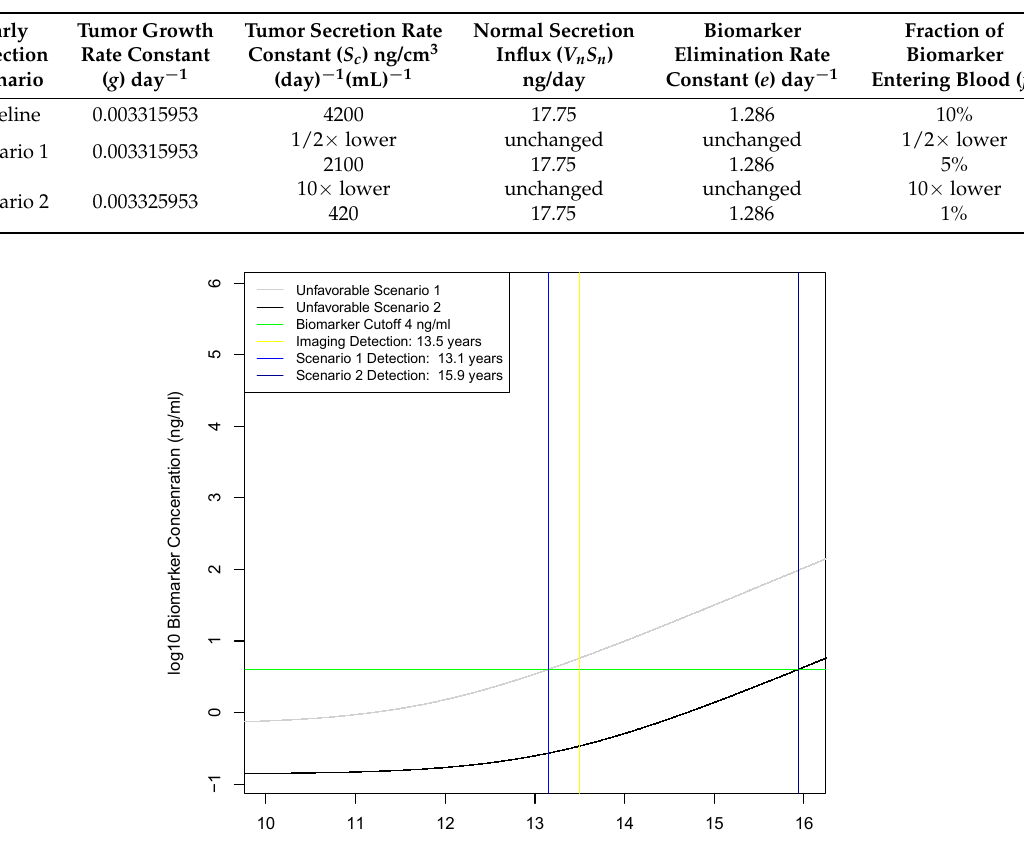
Figure 5. Investigation of two unfavorable scenarios on earliest detection times. Scenario 1 is 1/2 reduction in tumor biomarker secretion rate and 1/2 reduction in fraction of biomarker entering the blood, which results in an earliest detection time of 13.1 years that is slightly earlier than the 13.5 year threshold for detecting disease by imaging. Scenario 2 is a 10-fold reduction in the tumor biomarker secretion rate and a 10-fold reduction in the fraction of biomarkers entering the blood, which results in an earliest detection time of 15.9 years. Therefore, order of magnitude decreases in tumor secretion rates and fraction entering the blood result in significantly later detection times than imaging.